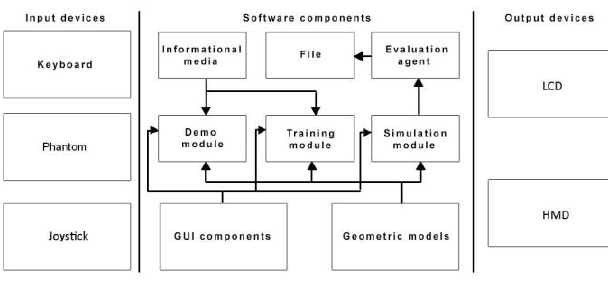
Fig. 2. Hardware and software diagram.